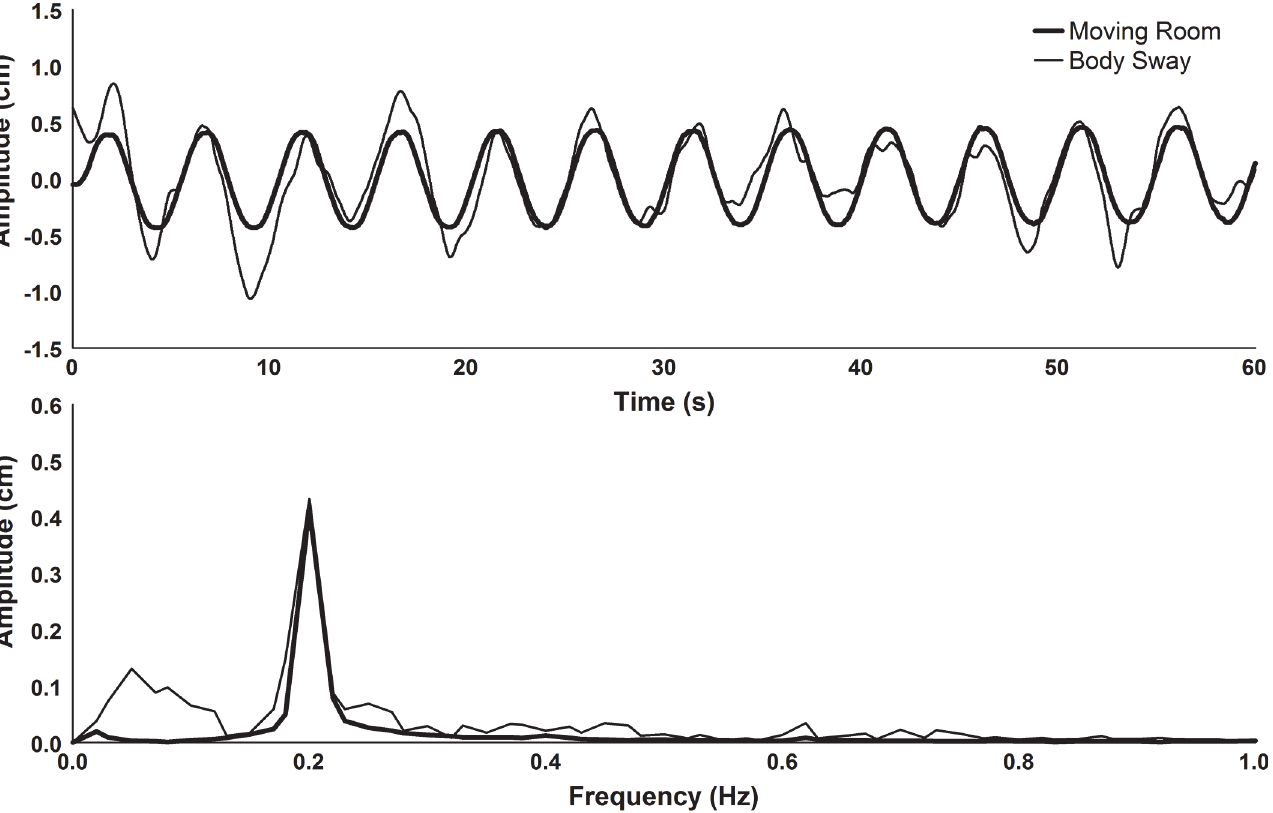
Fig 2. Time-series and amplitude spectra of body oscillation and moving room displacement of a representative subject of the control group during a pre-change trial.